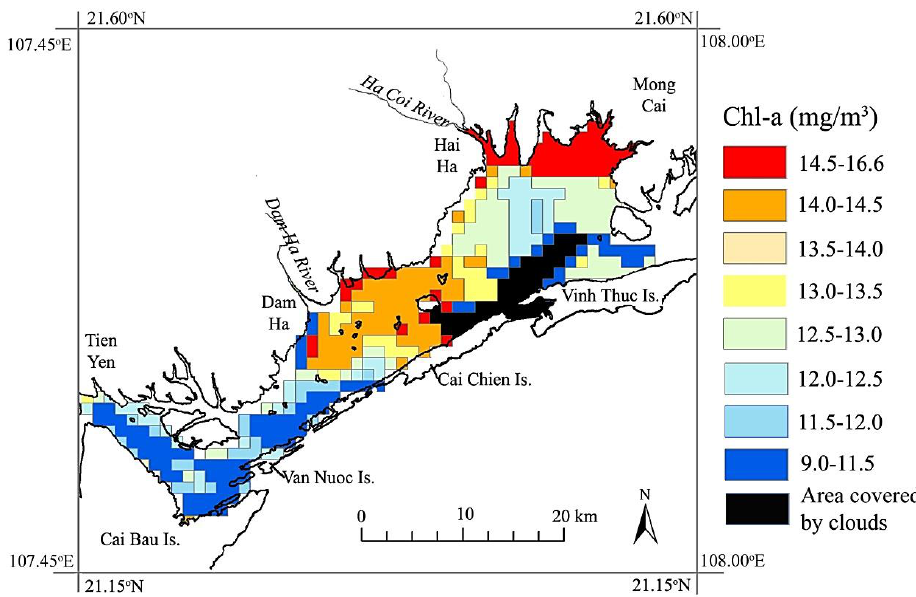
Figure 4. Spatial distribution of Chl-a concentrations over Tien Yen Bay on 6 July 2010, with a 1-km interval using MODIS image data and rGBr.